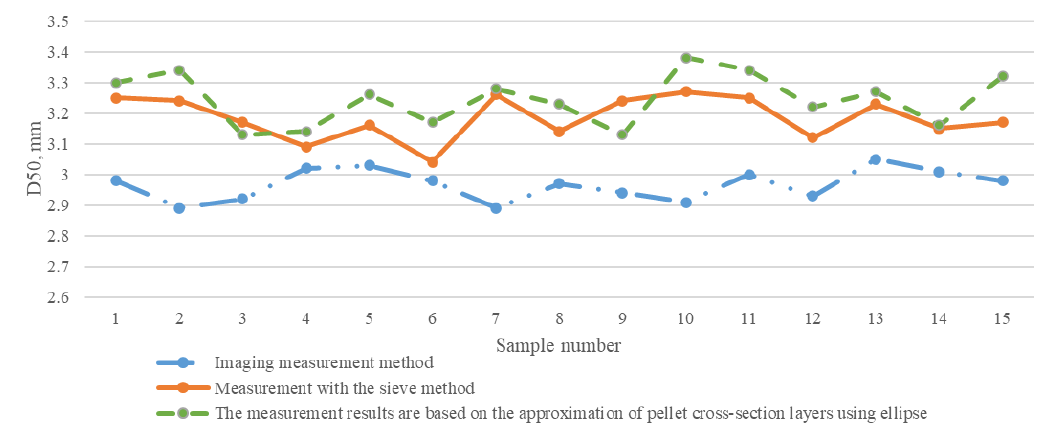
Figure 18. Average diameter of pellet from different samples (D 50 ).